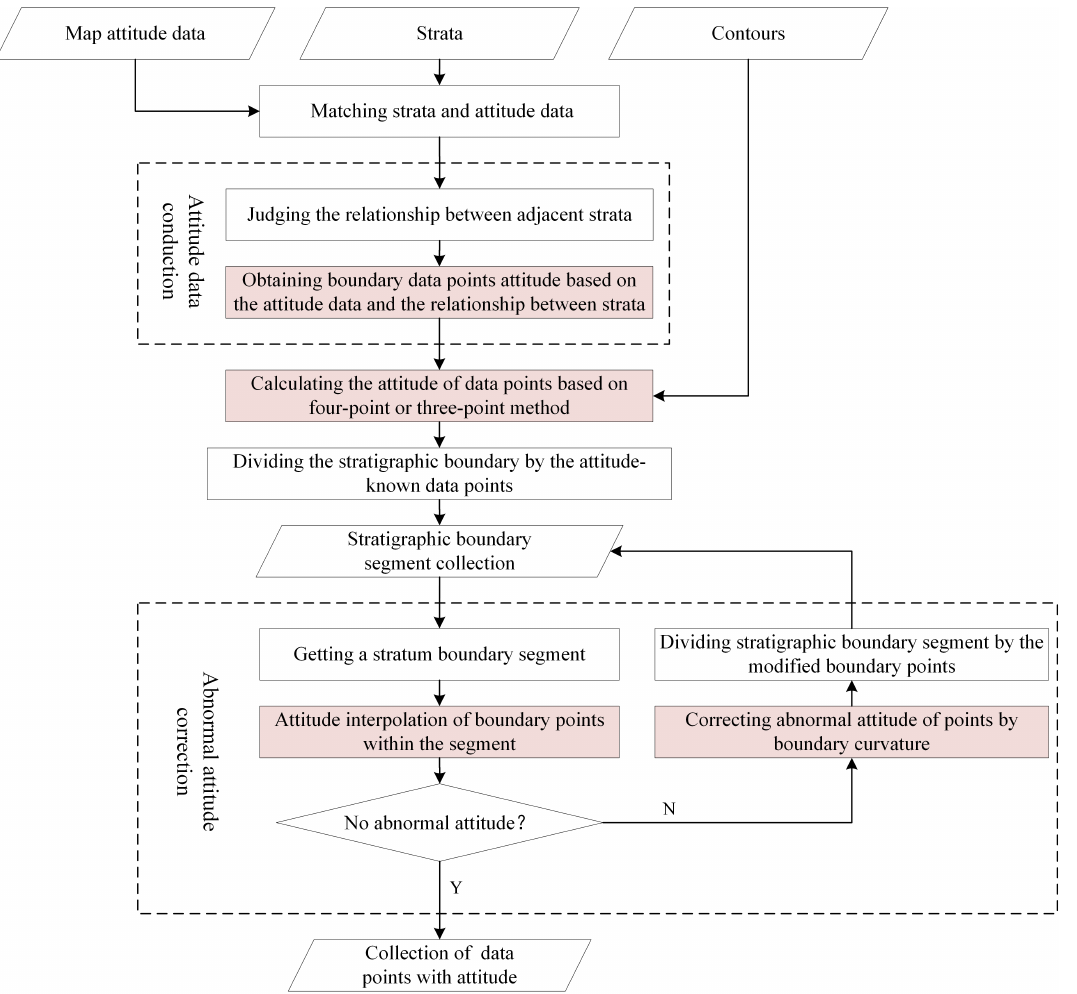
Figure 2. Flowchart of attitude calculation. Among them, the pink blocks represent important steps in the attitude calculation described in detail